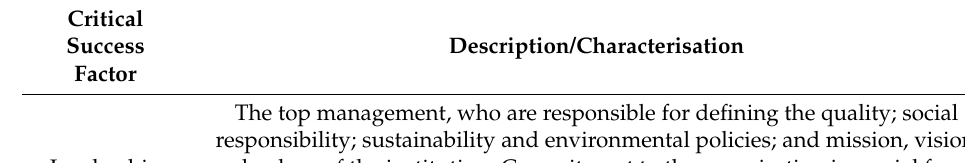
Table 1. Common critical success factors of TQM and